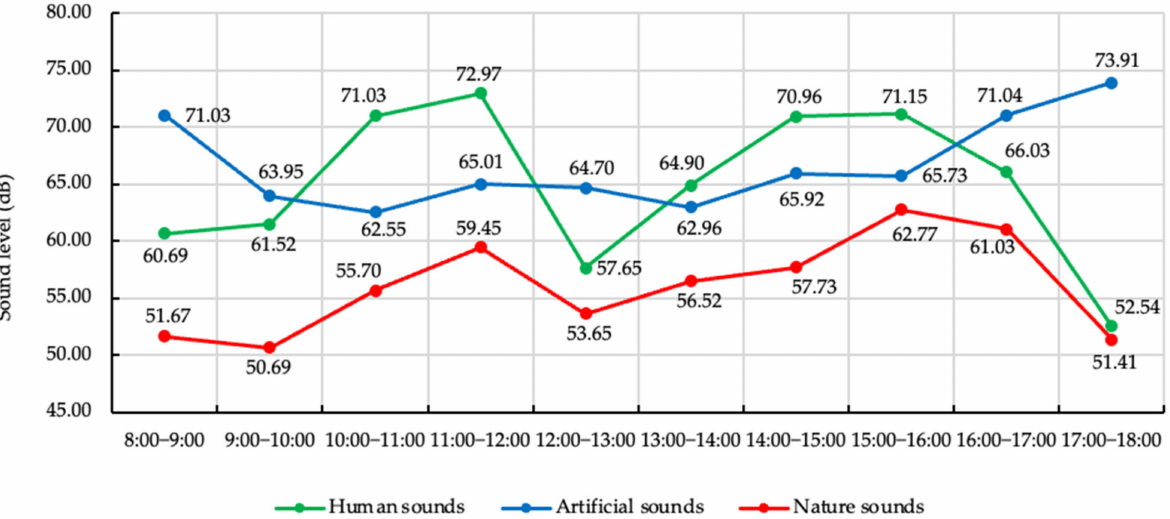
Figure 7. Sound levels at different time periods of each type of sound. The figure was created by the